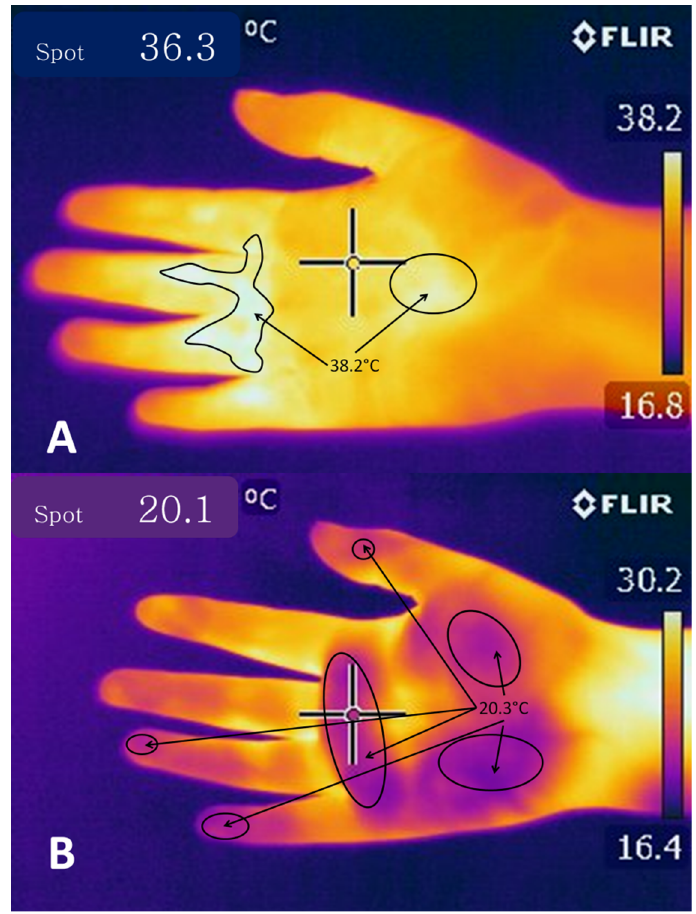
Figure 3. Thermograms of a hand subjected to ( A ) heat and ( B ) cold for 30 s. These images show that in response to a hot stimulus, a larger area of the palm presents a temperature of 36.3 ◦ C with a maximum of 38.2 ◦ C in the center and around the proximal and distal transverse creases. In contrast, in response to a cold stimulus, most of the palm—marked with ellipses—and the fingers present a temperature around 20.3 ◦ C, while only the wrist, the center of the palm, and a small area of interdigital spaces have a maximum of 30.2 ◦ C. Observations show that heat is distributed across almost the entire surface of the palm in response to a hot stimulus due to heat-induced vasodilatation. In response to a cold stimulus, in contrast, the surface temperature decreases, and heat concentrates in strategic points due to peripheral vasoconstriction. (Images obtained with a FLIR E 50 camera with an 18-mm FOL lens at a resolution of 240 × 180 pixels, (emissivity = 0.95, distance = 0.5 m)).